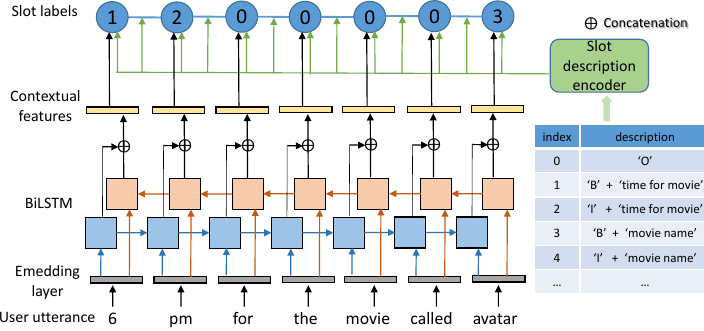
Figure 2. The architecture of the elastic CRF (eCRF)